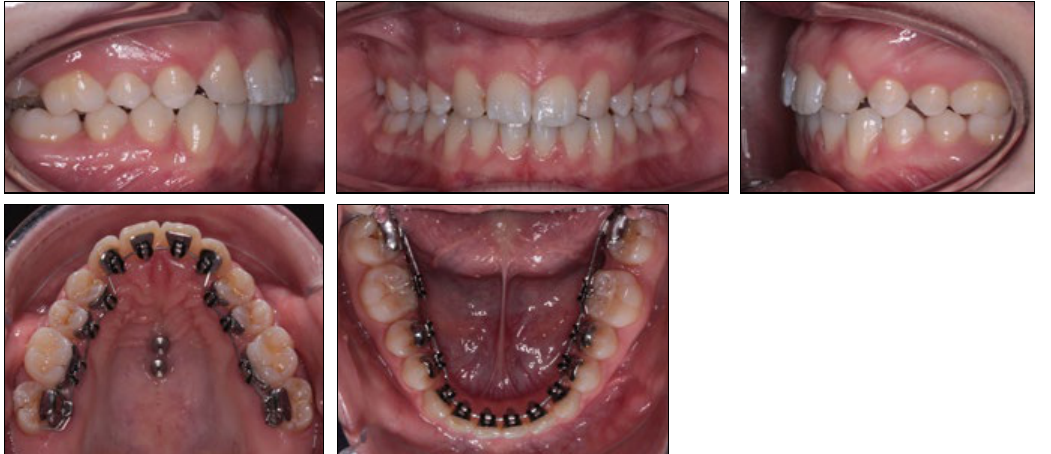
Figure 12. Intraoral photographs illustrating the intrusion steps of the 0.0175 × 0.0175 inch TMA wire to prepare for the later reshaping of the first premolar